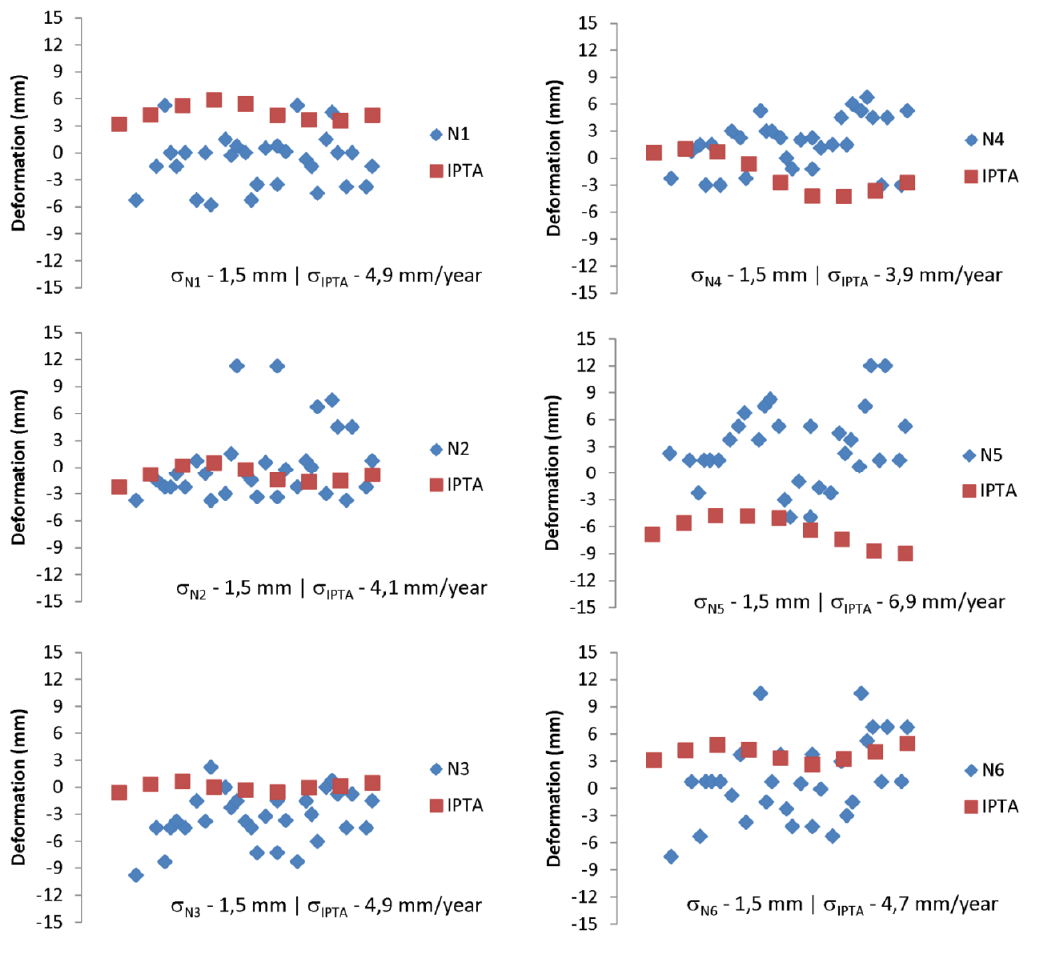
Figure 8. LOS deformation history derived from optical leveling and the IPTA processing for the period from June to September 2012, for the six sites. The differences in spatial location between the PS and the optical leveling are of few meters. The accuracy of each approach is indicated by its standard